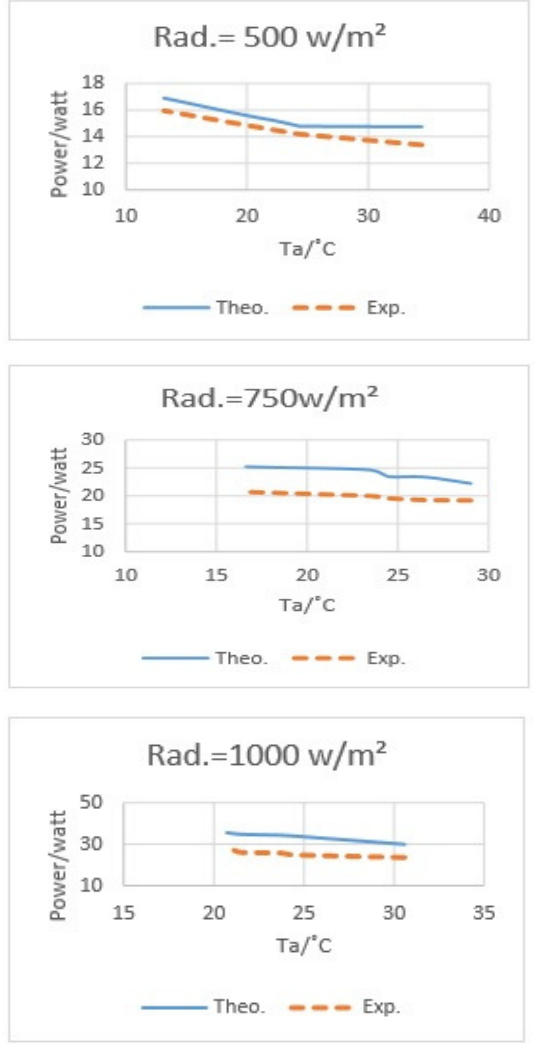
Fig. 7. Effect of ambient temperatures on power of monocrystalline PV solar cell at different radiation